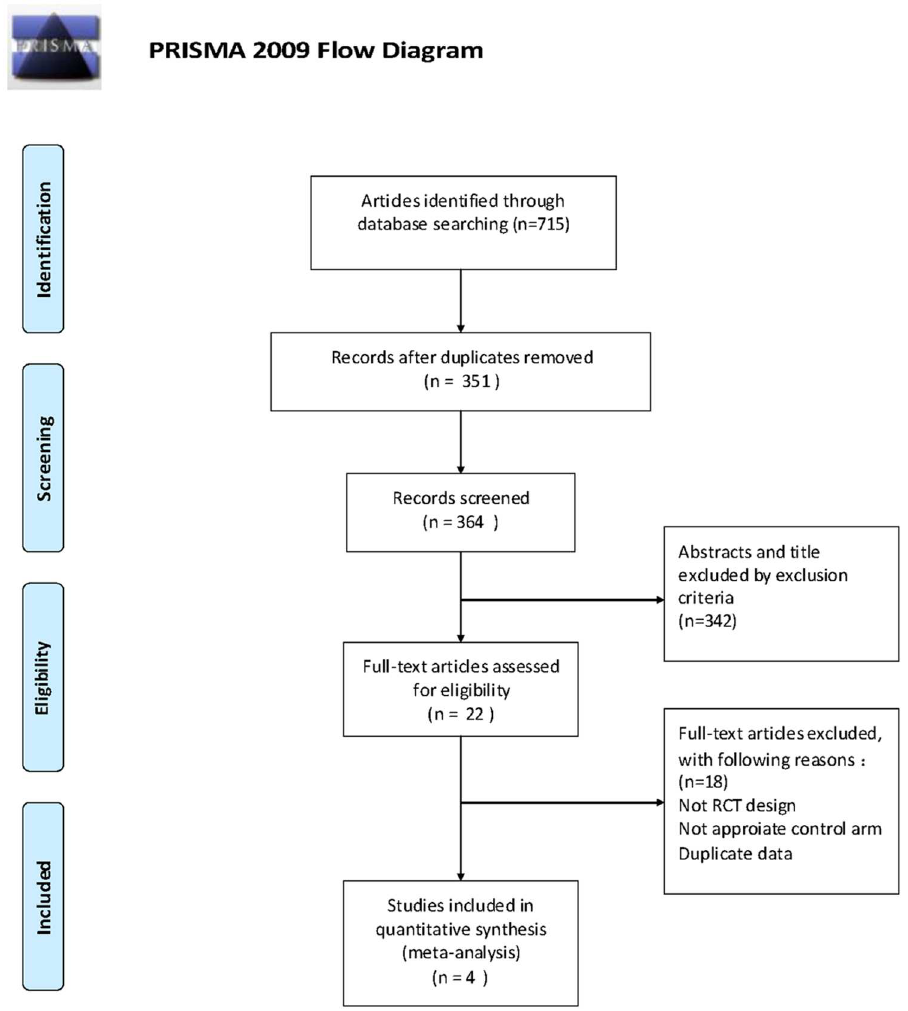
Fig 1. Selectionand evaluationprocess of the eligiblestudiesin the meta-analysis. From : MoherD, LiberatiA, Tefclaff J, AltmanDG, The PRISMA Group(2009)./deferred Reporting/ternsfor Systematic